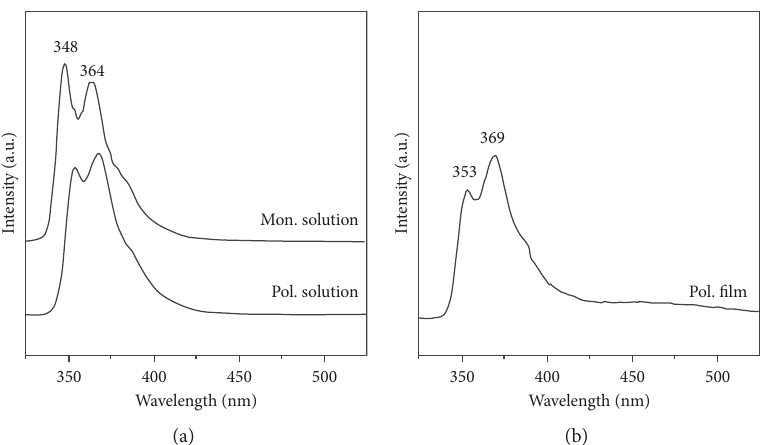
Figure 8: (a) Fluorescence spectra of polymer solution (sample 2 , THF 10 -4 M) and monomer solution (THF 10 -4 M). (b) Fluorescence spectrum of polymer fi lm. ( Λ = 300nm ecc